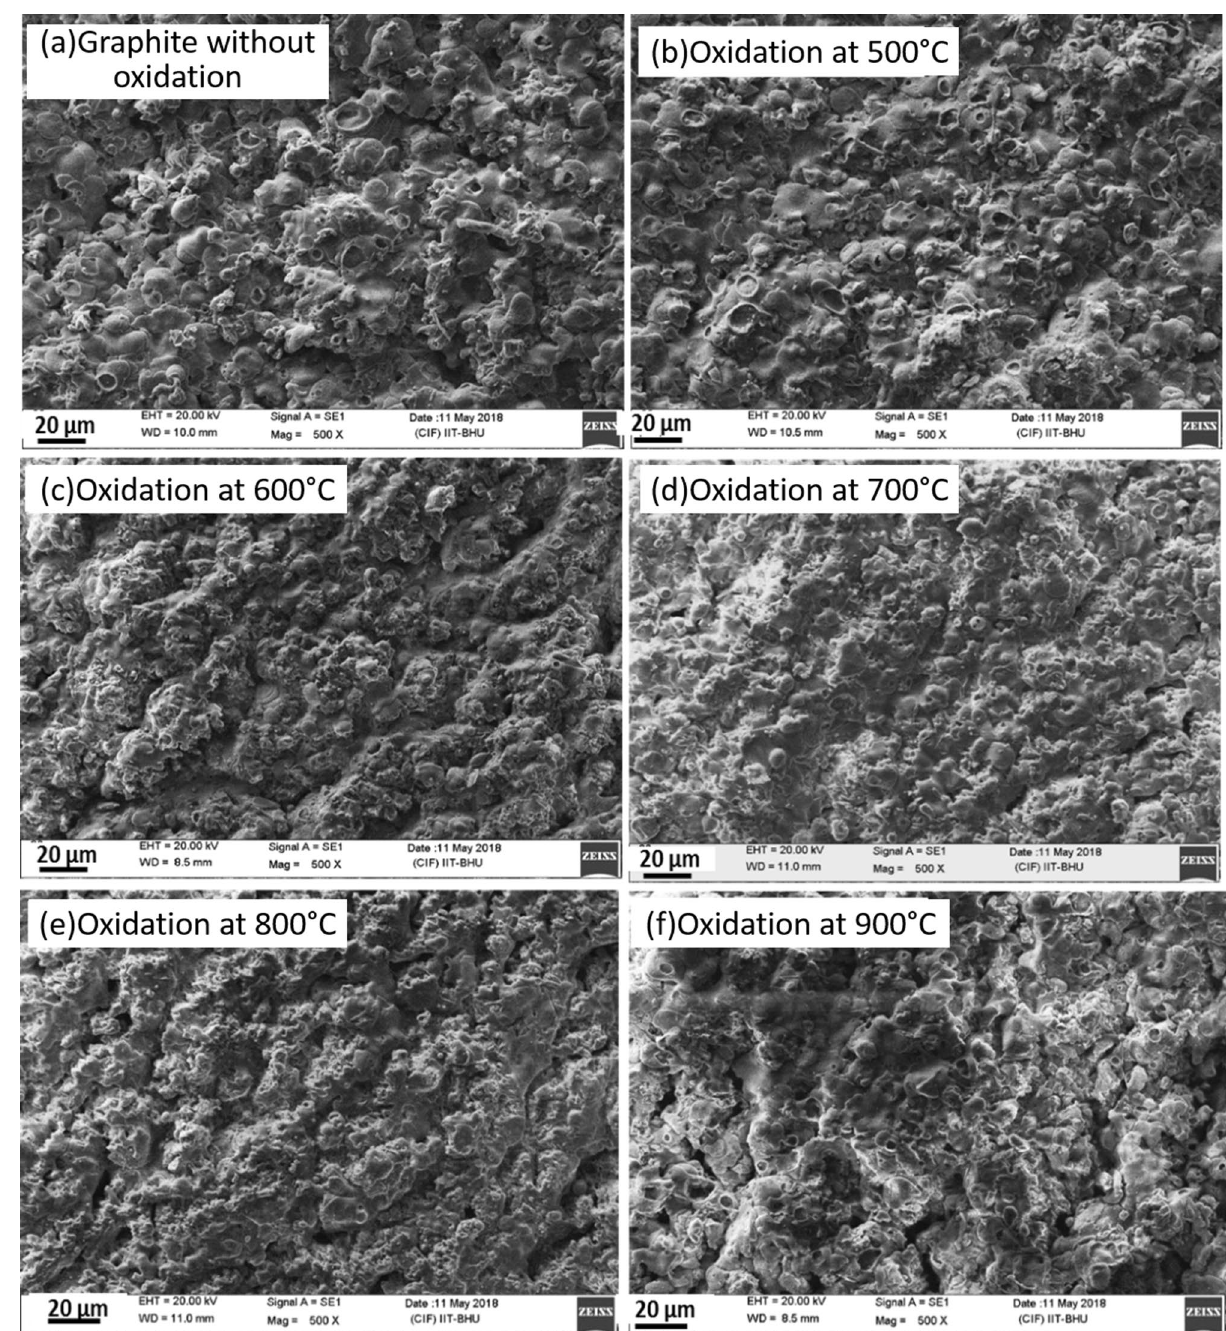
Figure 8. SEM analysis of residual Al 2 O 3 coated graphite specimens without removing coating